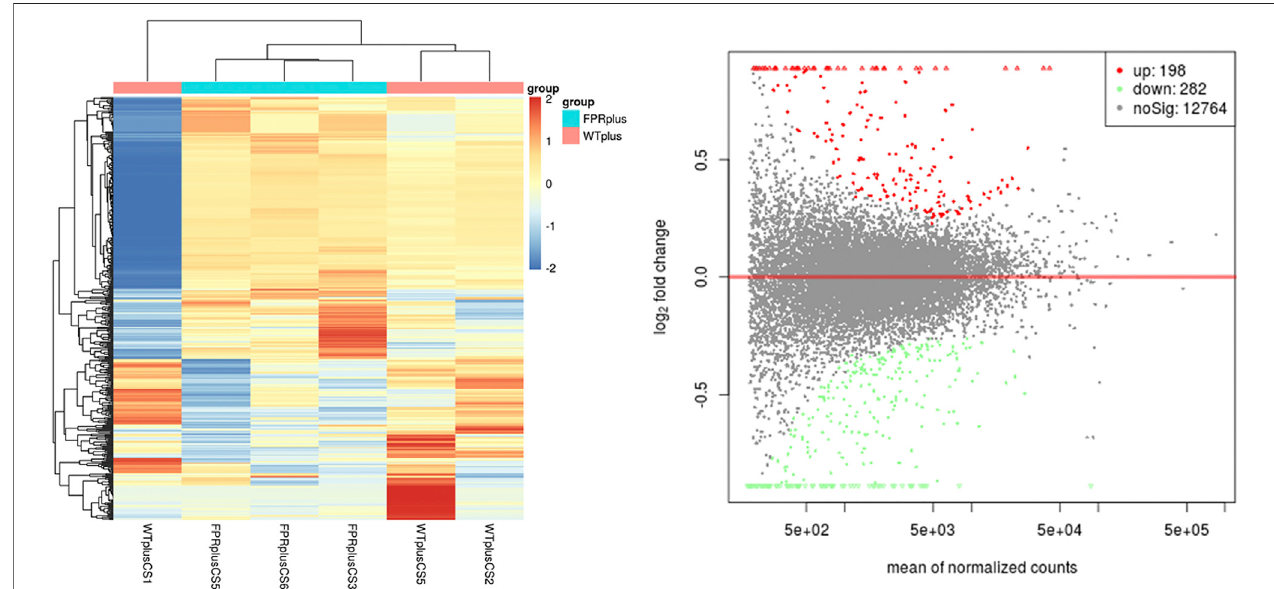
FIGURE 3 | mRNA expression between the WT + CS group and KO + CS group. (A) Heat map of mRNAs from mice lung tissues in the WT + CS group and KO + CSgroup. Each column represents theexpression pro fi les ofamouse lungtissue, andeach row corresponds tomRNA. “ Red ” indicates thehigher expression leveland “ blue ” indicates the lower expression level. (B) MA plots comparing the expression of mRNAs between the WT + CS group and KO + CS group. The red dots represent up-regulated mRNAs having p values < 0.05 in the two groups; the green dots represent down-regulated mRNAs having p values < 0.05. Abbreviations: CS, cigarette smoke; WT, wild type; KO, knockout.